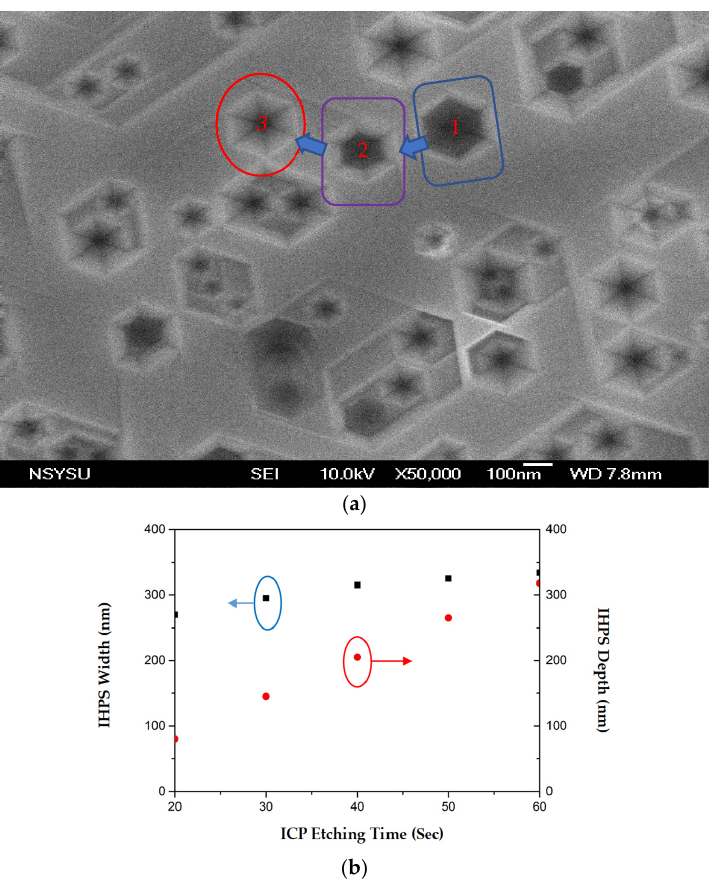
Figure 3. ( a ) Top-view FESEM images showing the procedure for the formation of the IHPS on the top surface of GaN-based LEDs: steps 1, 2 and 3. ( b ) Effect of the ICP etching time on changes in the width and depth of` the IHPS on the surface of p-GaN.